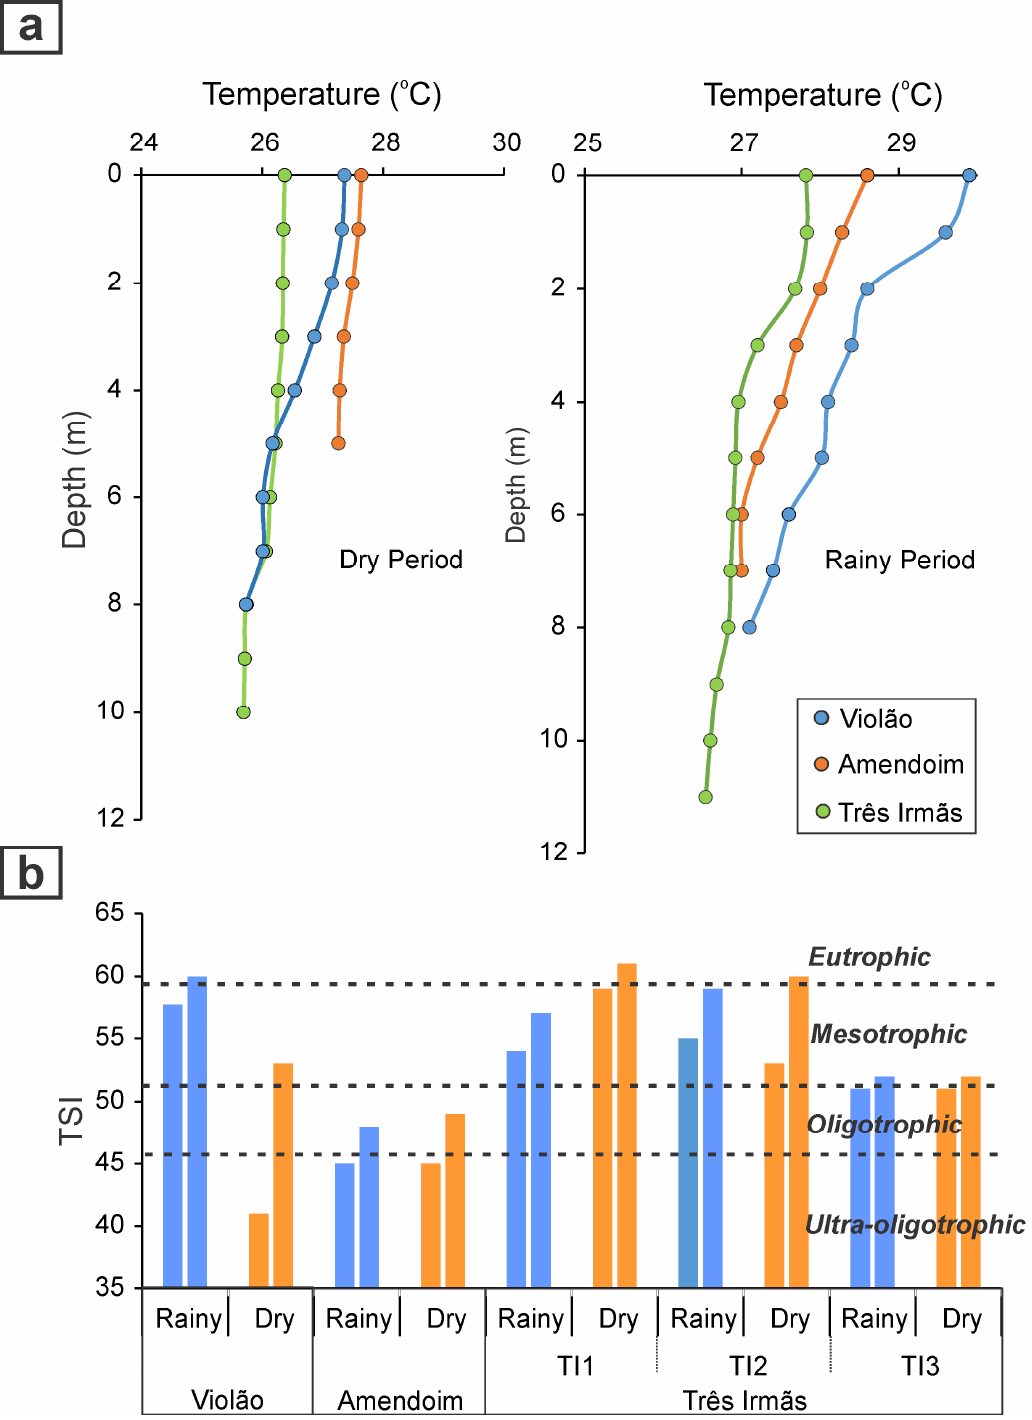
Figure 6. Vertical temperature profile in Violão, Amendoim and Três Irmãs lakes during the dry and rainy seasons showing the thermal stratification of the lakes ( a ), and trophic state index (TSI) of the lakes during both dry and rainy seasons ( b ), showing the significant variation in trophic state among lakes [10].